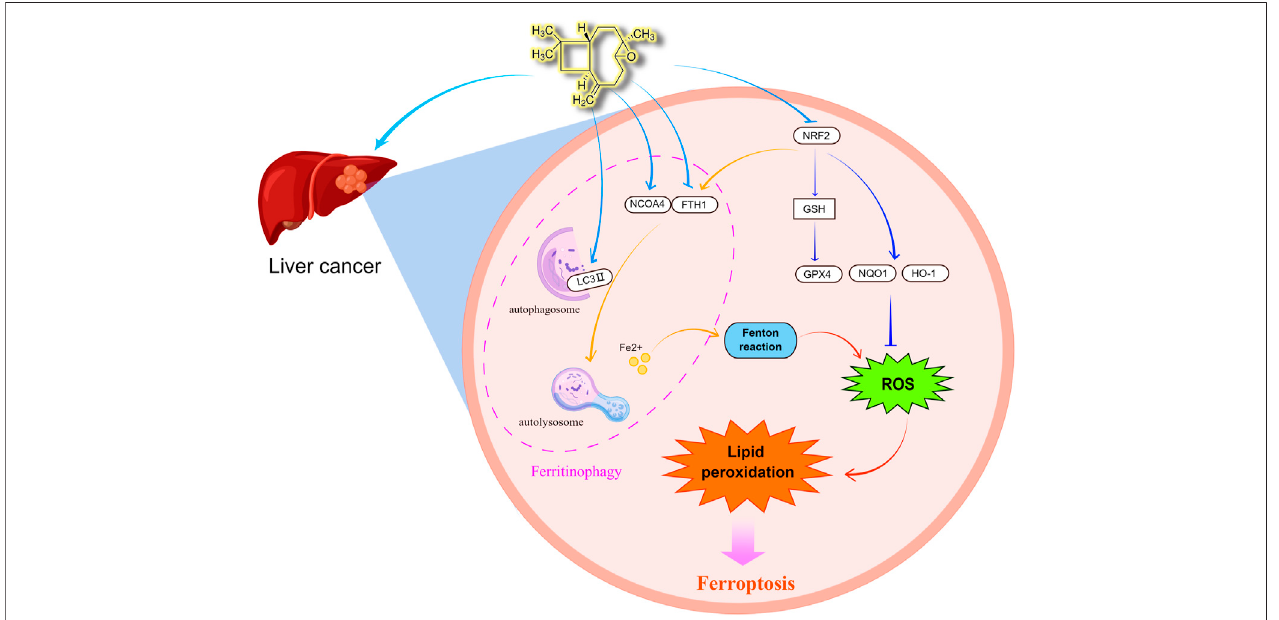
FIGURE 9 | Caryophyllene oxide can regulate the expression of NCOA4 and FTH1, increase the level of autophagy regulated by lysosome and LC3 II, and then degrade ferritin to the release of free iron, consequently triggering ferritinophagy. When a cell accumulates a large amount of free iron, the Fenton reaction produces hydroxylradical(OH · )thatincreasestheformationofROSandcausesoxidativestress.WhenalargeamountofROSaccumulatesincells,itcanleadtotheaccumulation of lipid peroxidation and induce cell ferroptosis. Simultaneously, caryophyllene oxide can inhibit GSH expression by inhibiting the NRF2 signal pathway, therefore inhibit the expression of its target protein GPX4, which is the star regulator protein of ferroptosis, as well as the expression of target proteins HO-1, FTH1, and NQO1, enhance the accumulation of ROS, and fi nally induce ferroptosis. By Figdraw (www. fi gdraw.com).